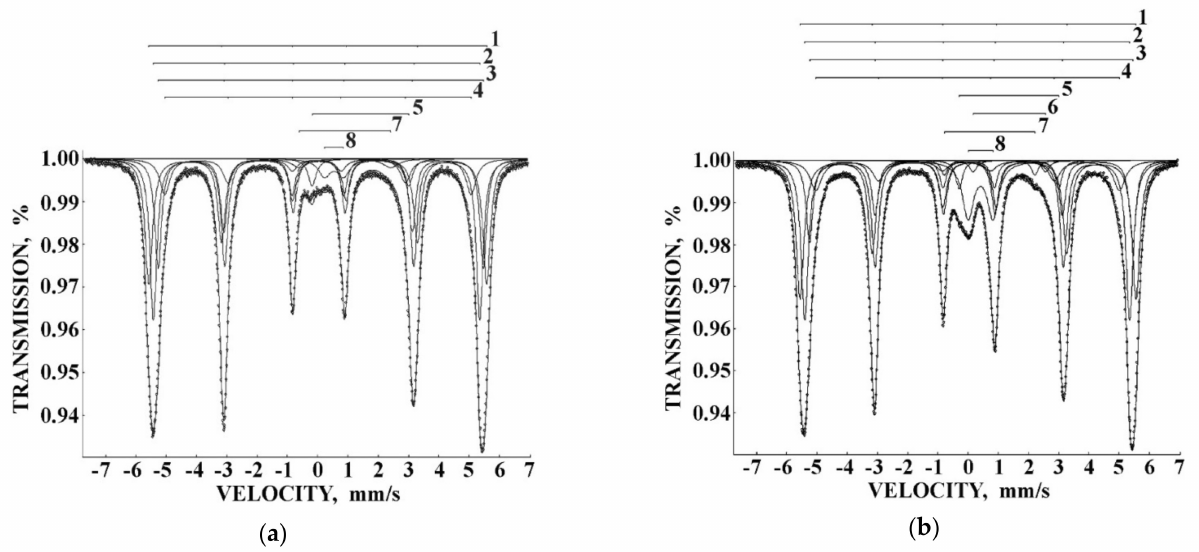
Figure 4. Room temperature Mössbauer spectra of carbonaceous chondrite Isheyevo CH/CBb: ( a ) internal and ( b ) external parts. Spectral components are described in the text. Adapted from Reference